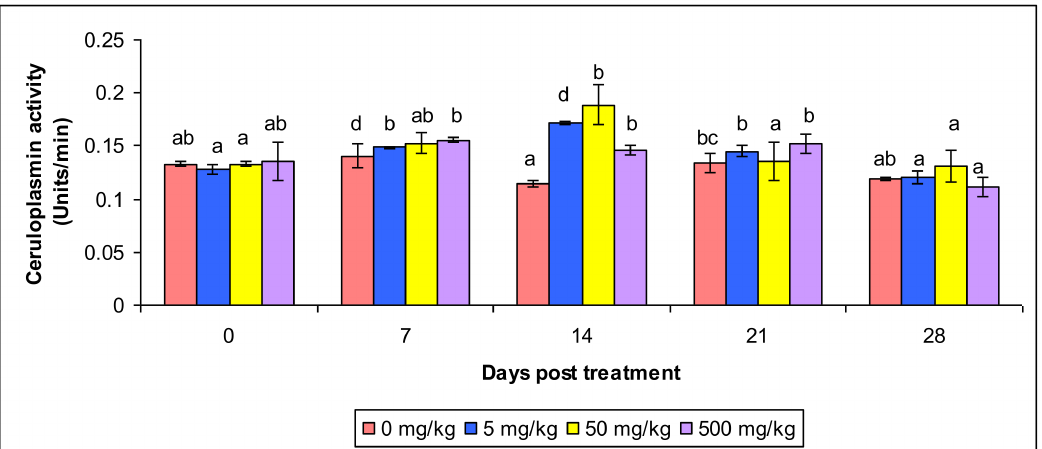
Figure 4. Ceruloplasmin activity under different treatments administered with various levels of C. aerea extract in L. rohita during post treatment days (values are mean ± SE). Mean values with different superscript within a column for a parameter are significantly different ( p < 0.05).